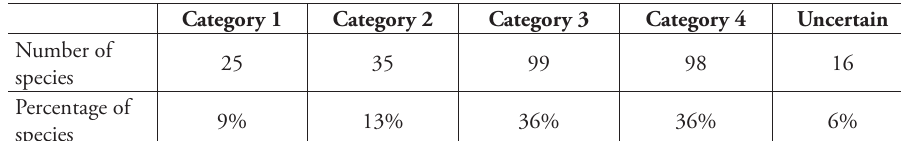
Table 2. Number of species per sphragis